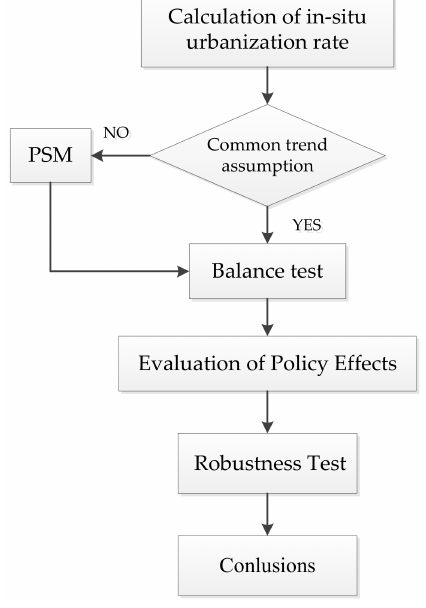
Scheme 1. Steps of empirical